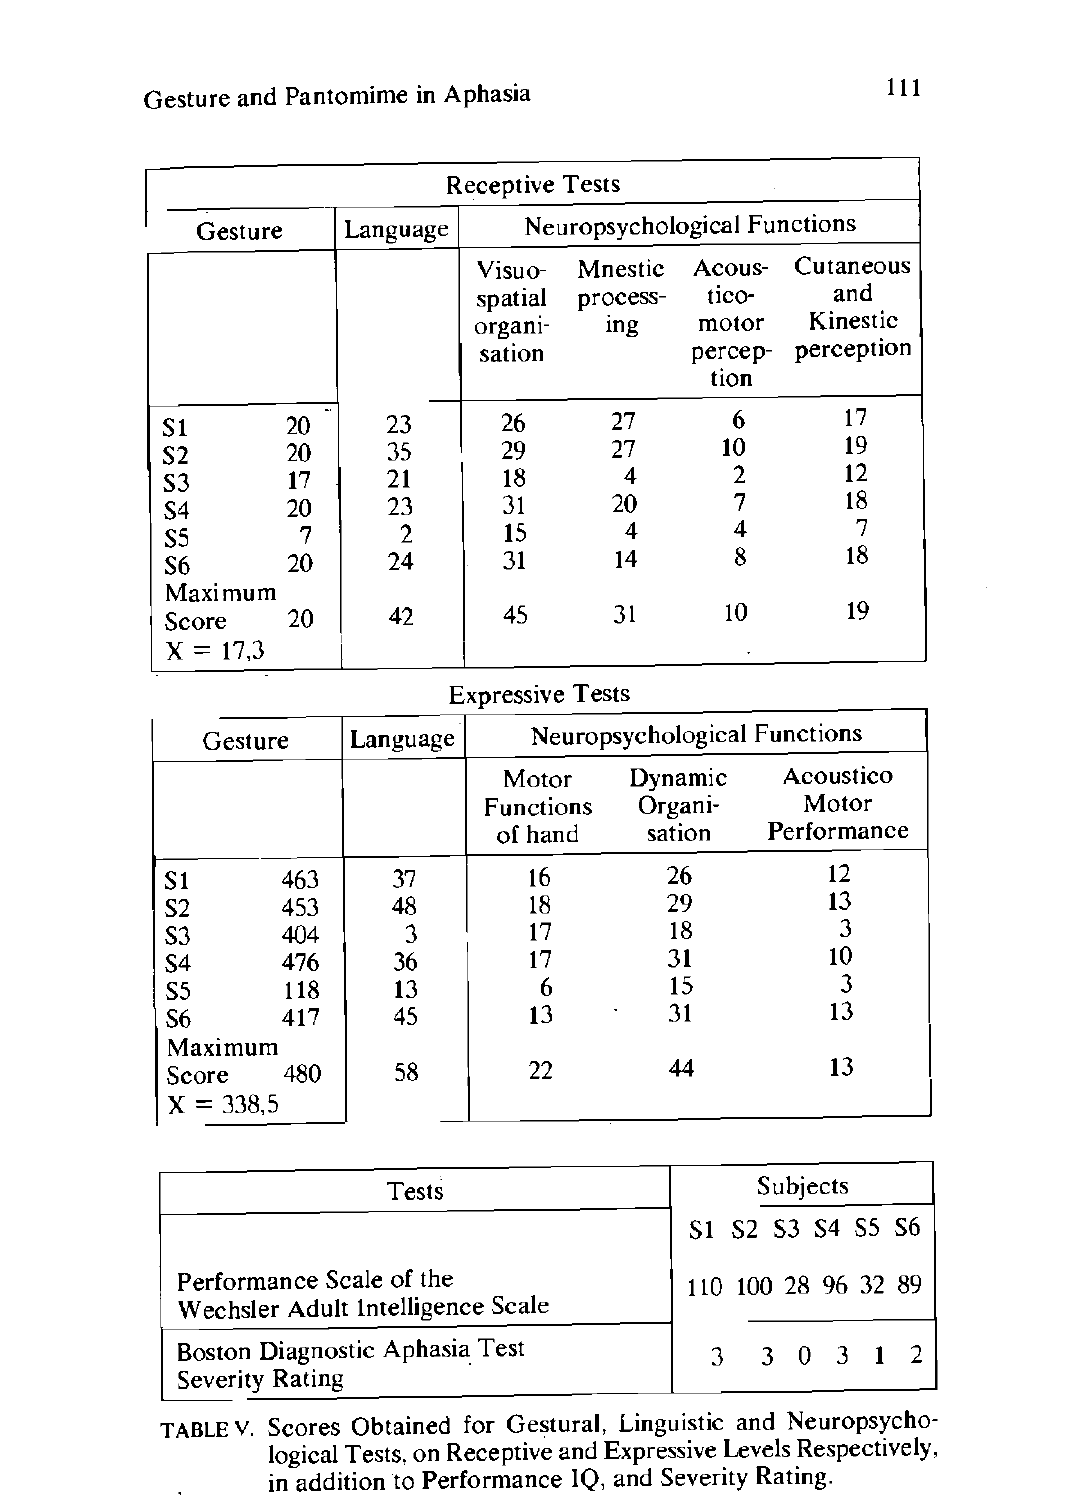
TABLE V. Scores Obtained for Gestural, Linguistic and Neuropsycho- logical Tests, on Receptive and Expressive Levels Respectively, in addition to Performance IQ, and Severity